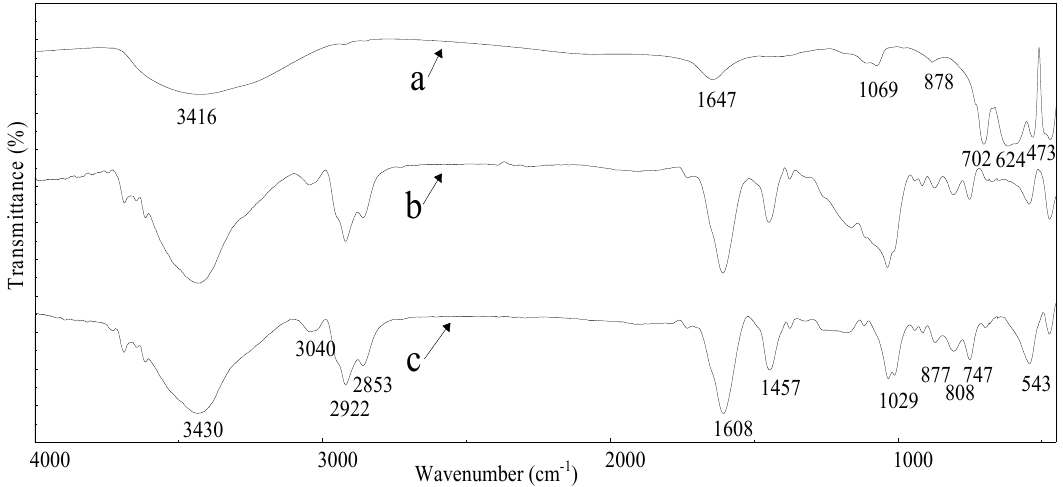
Figure 9. Fourier transform infrared spectroscopy of ROC ( a ), coking coal before adsorption ( b ) and Figure 9 . Fourier transform infrared spectroscopy of ROC (a), coking coal before adsorption (b). and coking coal after adsorption ( c coking coal after adsorption (c).